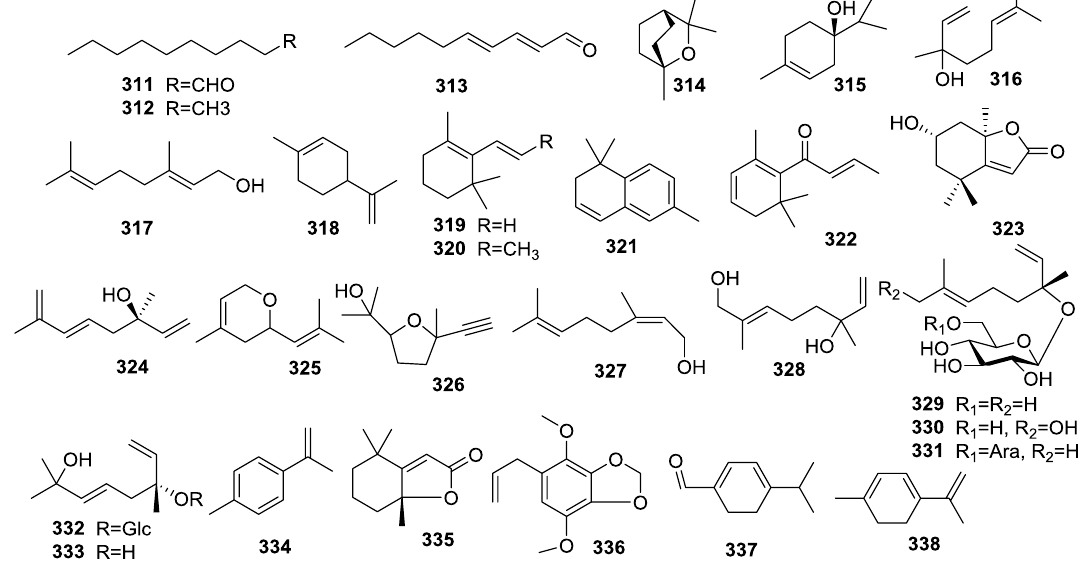
Fig. 7 Monoterpenes 311 – 338 from